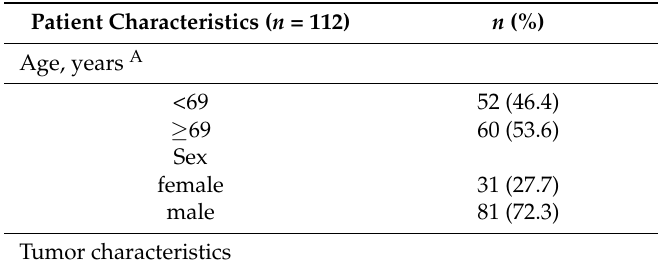
Table 1. Clinicopathological characteristics of the patients undergoing transurethral resection of the bladder or radical cystectomy.